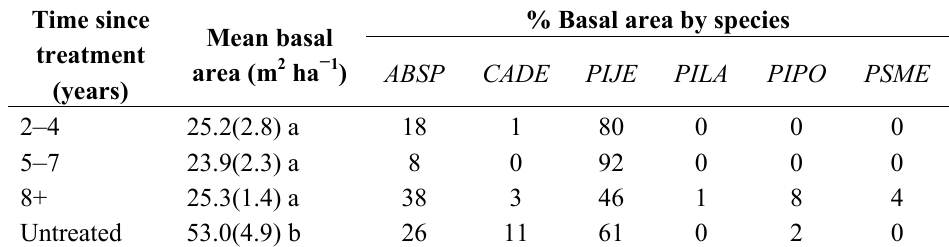
Table 4. Eastside pine mean basal area (standard error), and mean contribution of each tree species to total basal area for each time-since-treatment category. Different letters indicate significant difference in means between groups (Tukey’s HSD multiple comparison